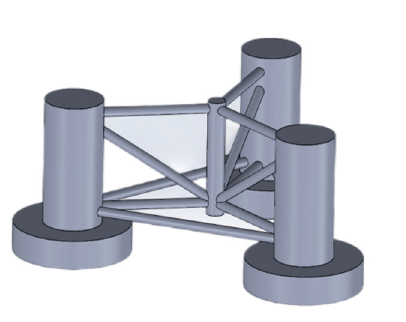
Figure 3. Simplified